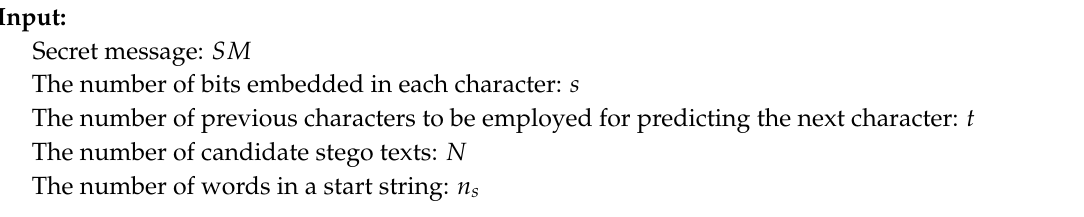
Algorithm 1 Information hiding